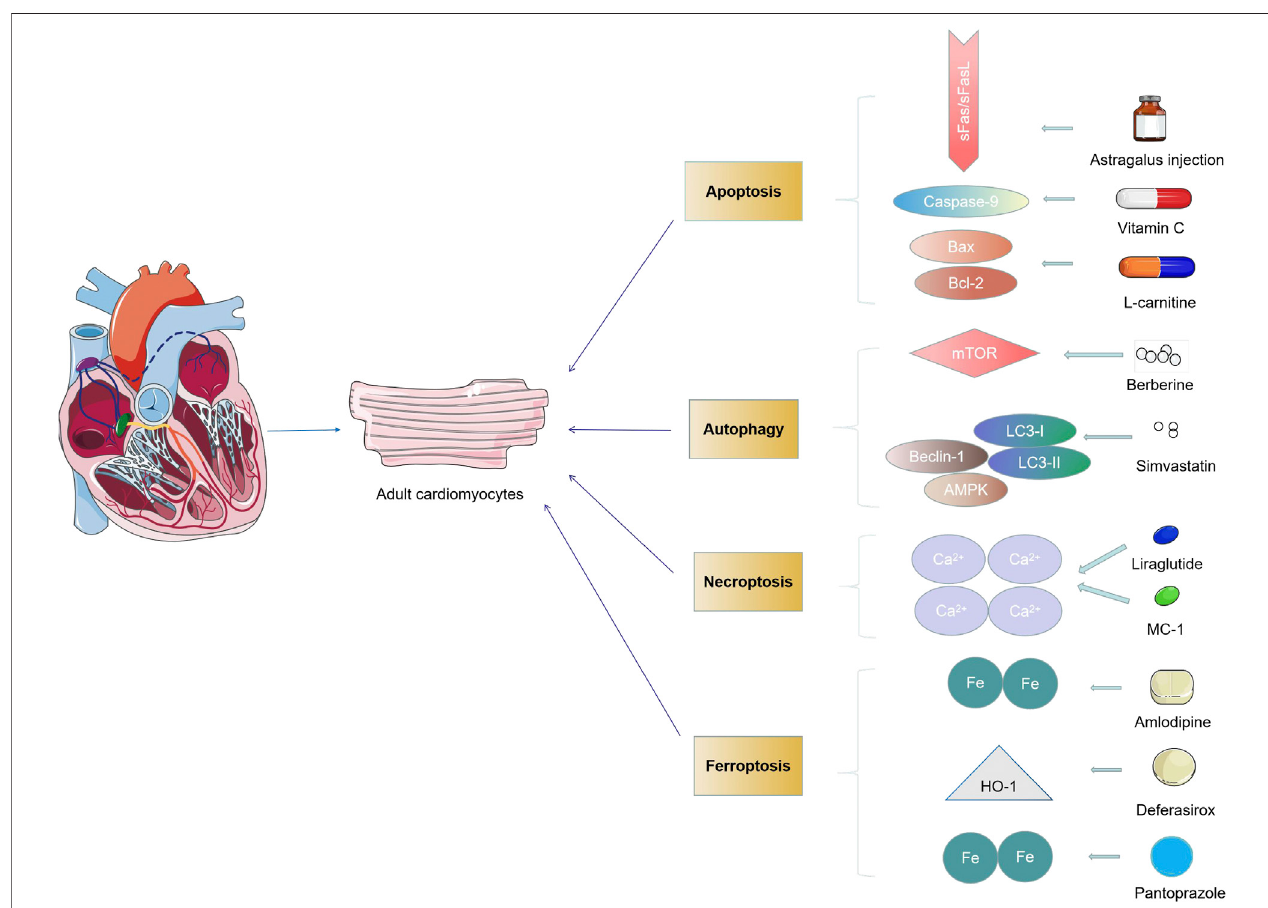
FIGURE 3 | Drugs target cardiomyocytes through different types of